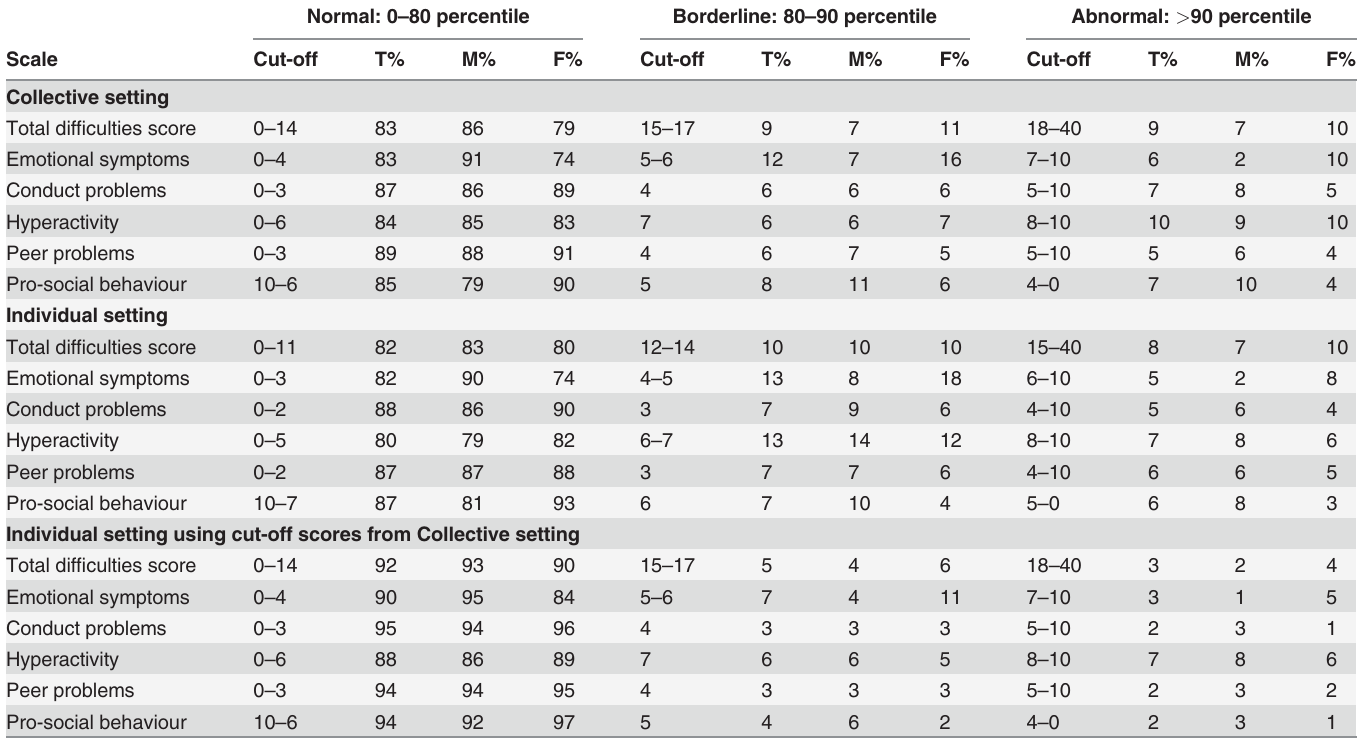
Table 5. SDQ cut-off scores and percentage of cases for the individual and collective setting based on the 80 th and 90 th percentile of these settings and the percentage of cases in the individual setting based on the cut-off scores in the collective